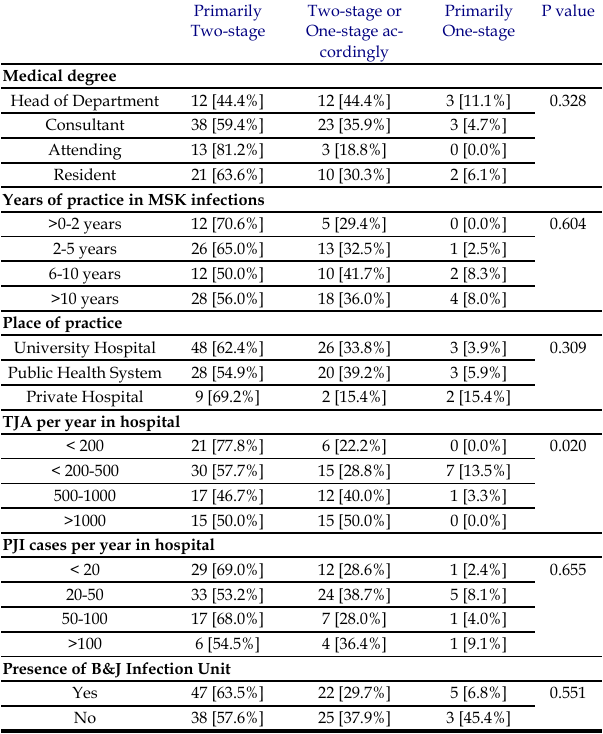
Table 5 . Personal, Local and Institutional Factors influence on chosen philosophy for revision